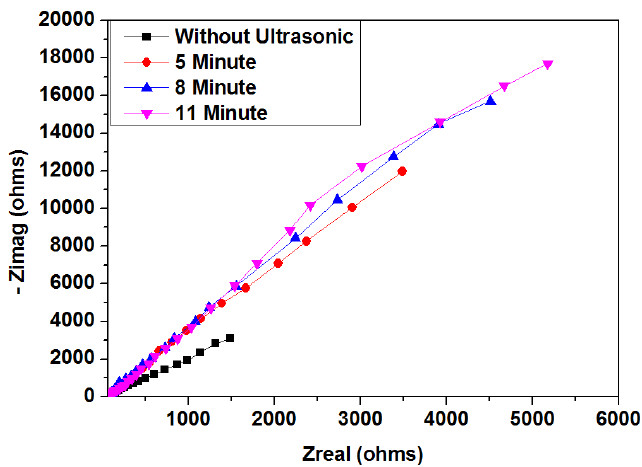
Figure 7. Nyquist plots for TiN-coated samples after ultrasonic treatment at 16 kHz for various exposure times (extreme high PVD condition).